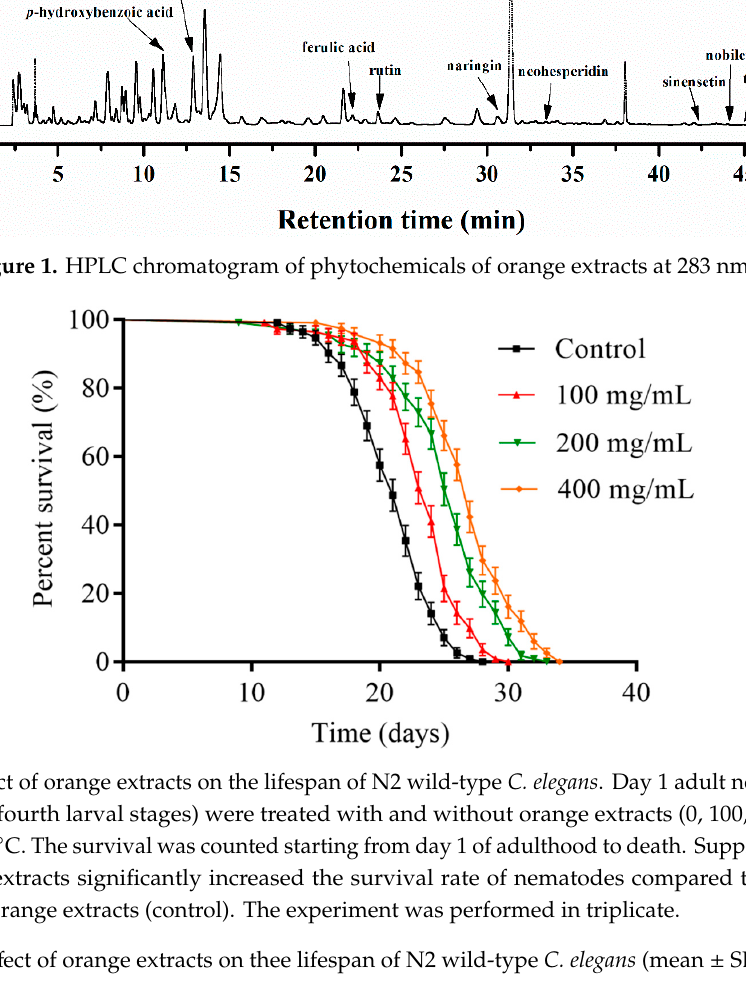
Figure 1. HPLC chromatogram of phytochemicals of orange extracts at 283 nm.